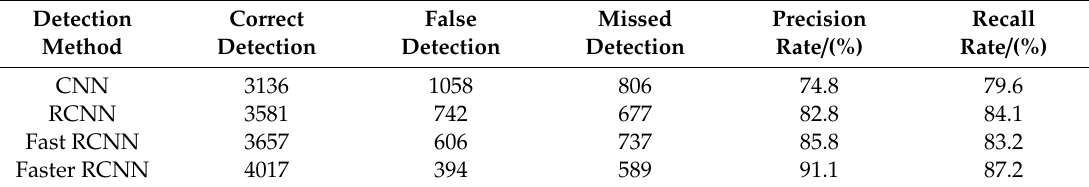
Table 2. Comparison of vehicle detection